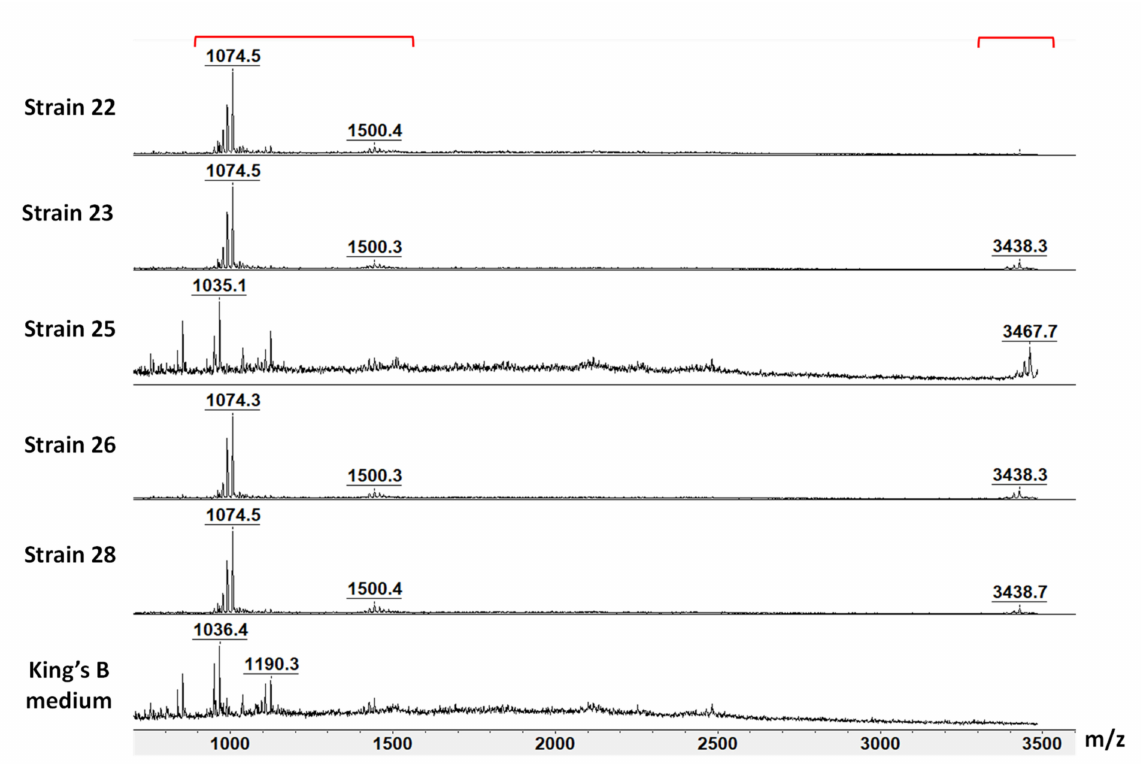
Figure 4. MALDI-TOF mass spectra of supernatant samples of B. subtilis (strain 22, 23, 26, 28), B. tequilensis (strain 25), and KB medium after 24 h cultures. Mass spectra represent ion intensity in the mass range of 800 to 3500 m / z . Brackets highlight the two groups of peaks